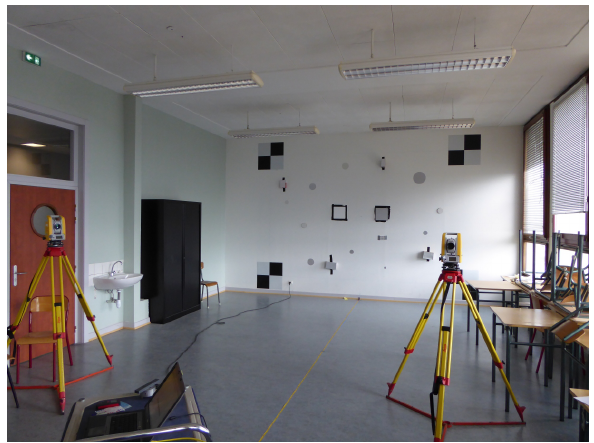
Figure 11. Stickers applied on the SR4500 camera to facilitate its localisation with the tachometer